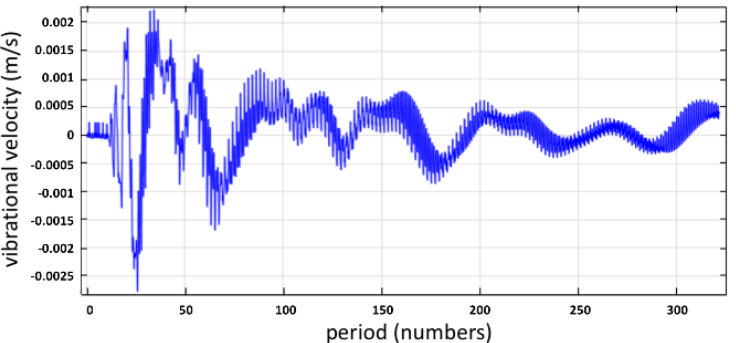
Figure 5. At the position (L/2, h), the vibrational velocity varies with the time period for h cr = 0.36 μ m .